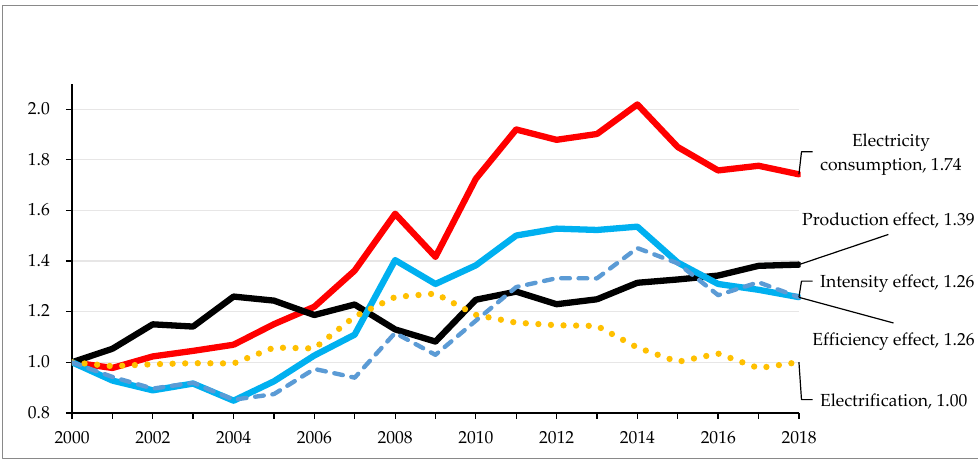
Figure A5. Nonmetallic electricity consumption LMDI results (fixed base year, multiplicative).